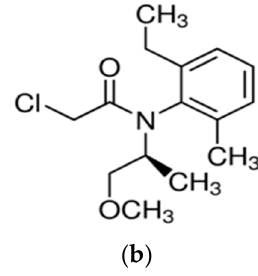
Figure 1. Molecular structures of acetochlor ( a ) and s-metolachlor ( b ).